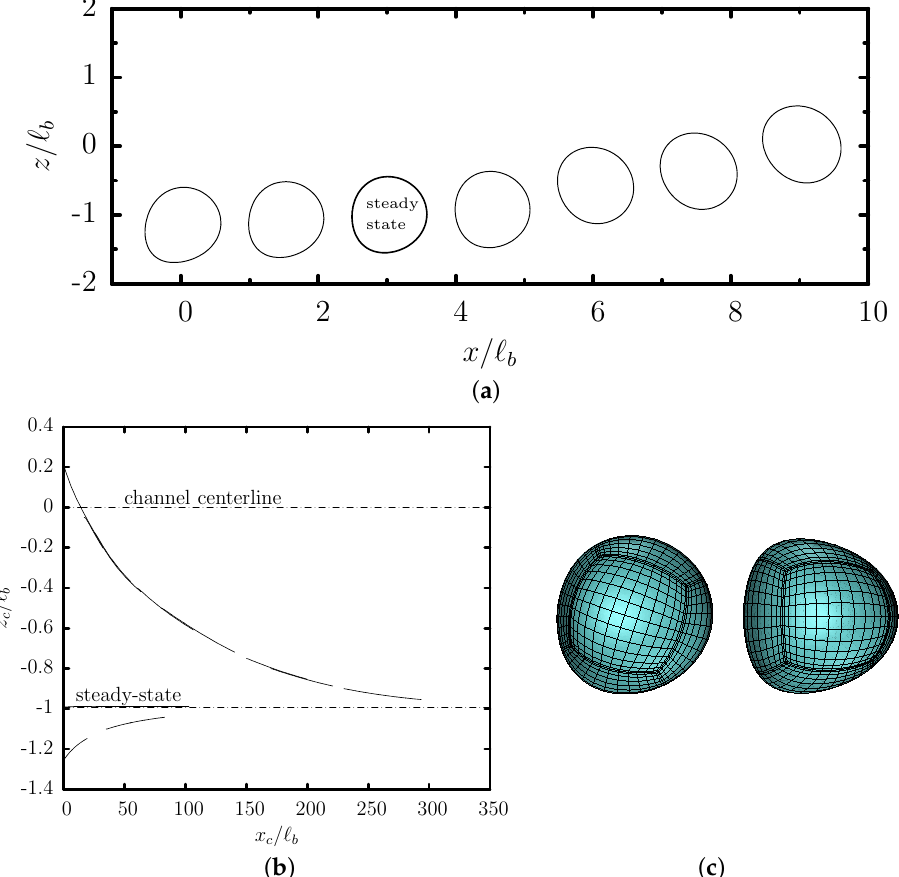
Figure 3. Evolution of a capsule with a / (cid:96) b = 0.55 and Ca = 0.1 flowing in a trapezoidal channel with height (cid:96) z / (cid:96) b = 2 and base ratio (cid:96) a / (cid:96) b = 0.25. ( a ) The quasi-steady front profile (i.e., intersection of the system surface with the plane y = 0) at centroid z c / (cid:96) b = These profiles were shifted along the x -axis to appear nearby but separated. ( b ) The capsule’s centroid z c versus its centroid x c , derived from our computations for different initial positions z 0 c / (cid:96) b in the range [ 1.25,0.2 ] . (Note that our steady-state computations which cover the x -distance [ 0,100 ] were − extrapolated to the entire x -range for optical reasons.) ( c ) Front and top views of the steady-state capsule